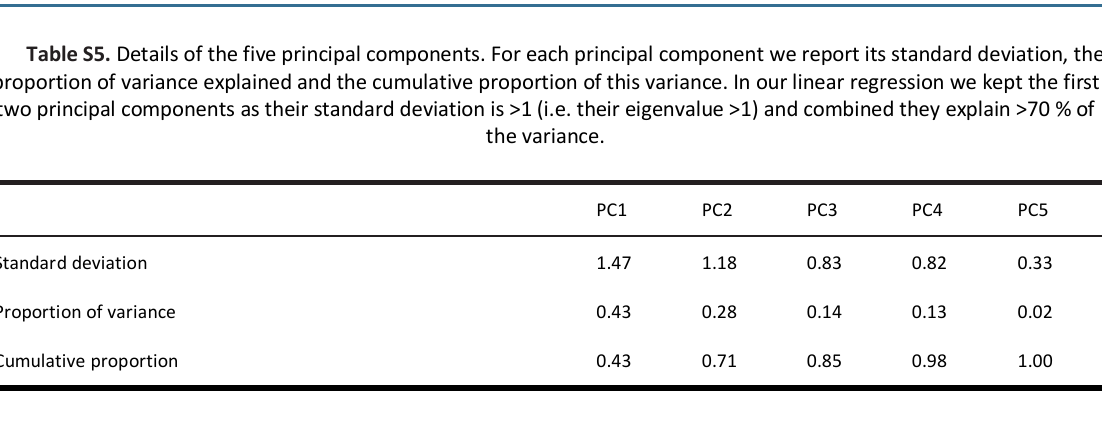
Table S6 . Loadings of the five original environmental variables from which the five principal components